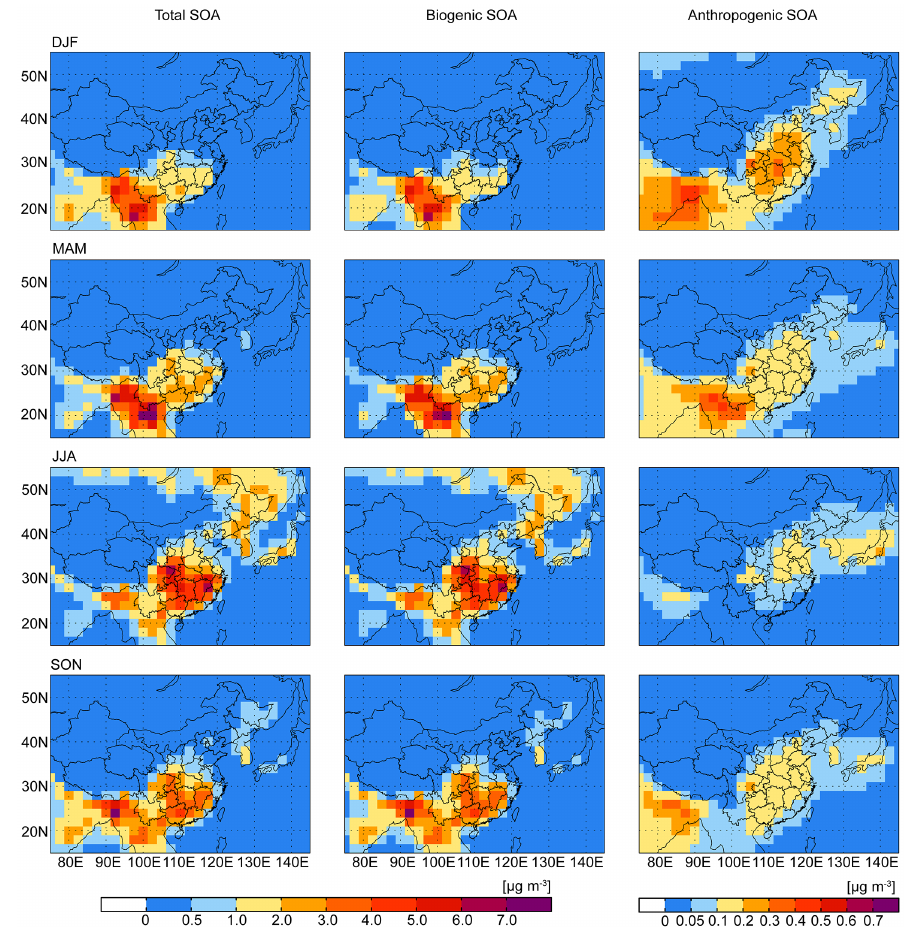
Figure 2. Seasonal mean surface concentrations of total secondary organic aerosols (SOA), biogenic SOA, and anthropogenic SOA in East Asia from the control ([ CTRL ]) simulation, averaged over 2007–2011.